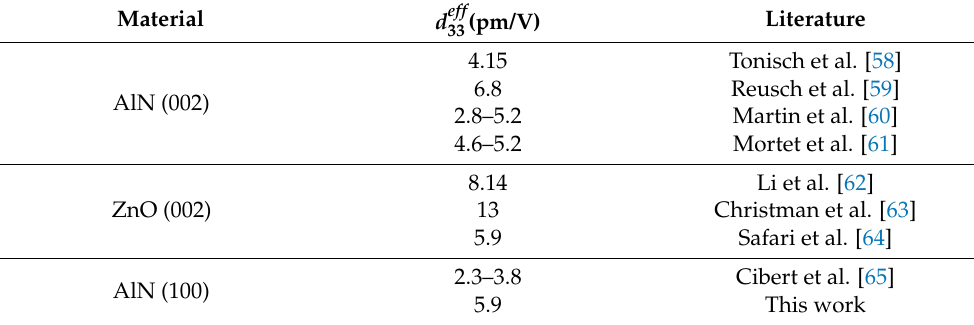
of AlN and ZnO thin 33